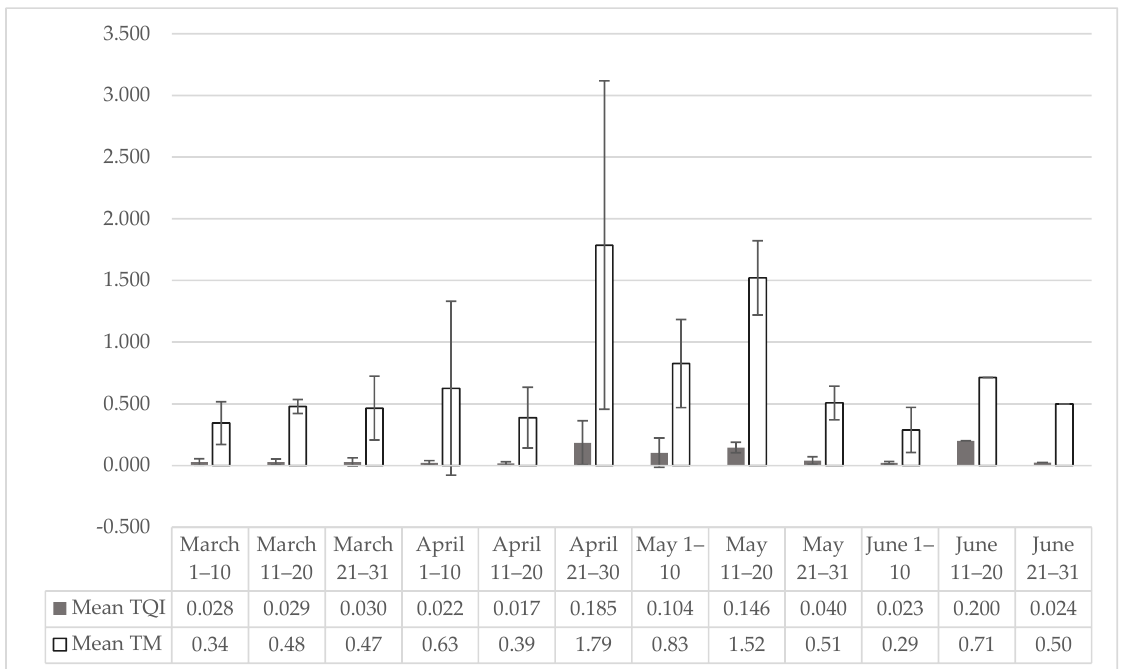
Figure 1. Dynamic of questing activity of I. ricinus represented by mean ± SD (TM and TQI) over the 5 years by 10 days period from March to June. TQI: total questing ticks index; TM: ticks per minute . Error bars represent standard deviations.